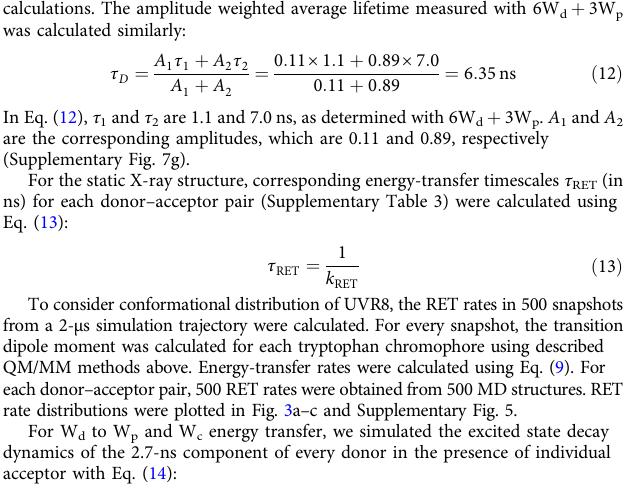
(Supplementary Fig. 7g). For the static X-ray structure, corresponding energy-transfer timescales τ RET (in ns) for each donor – acceptor pair (Supplementary Table 3) were calculated using Eq. (13):